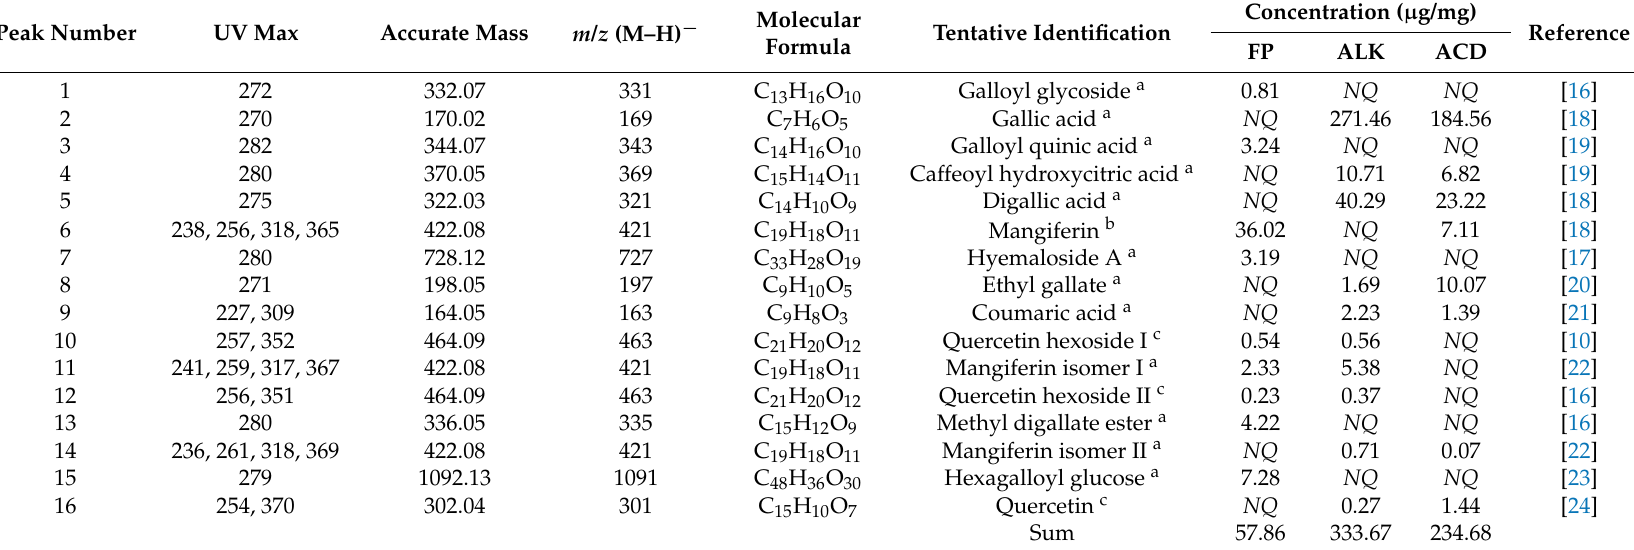
Table 1. Phenolic compounds found in free phenolics (FP), alkaline (ALK), and acid (ACD) hydrolysis extracts from mango Mangifera indica cv. Ataulfo peel.